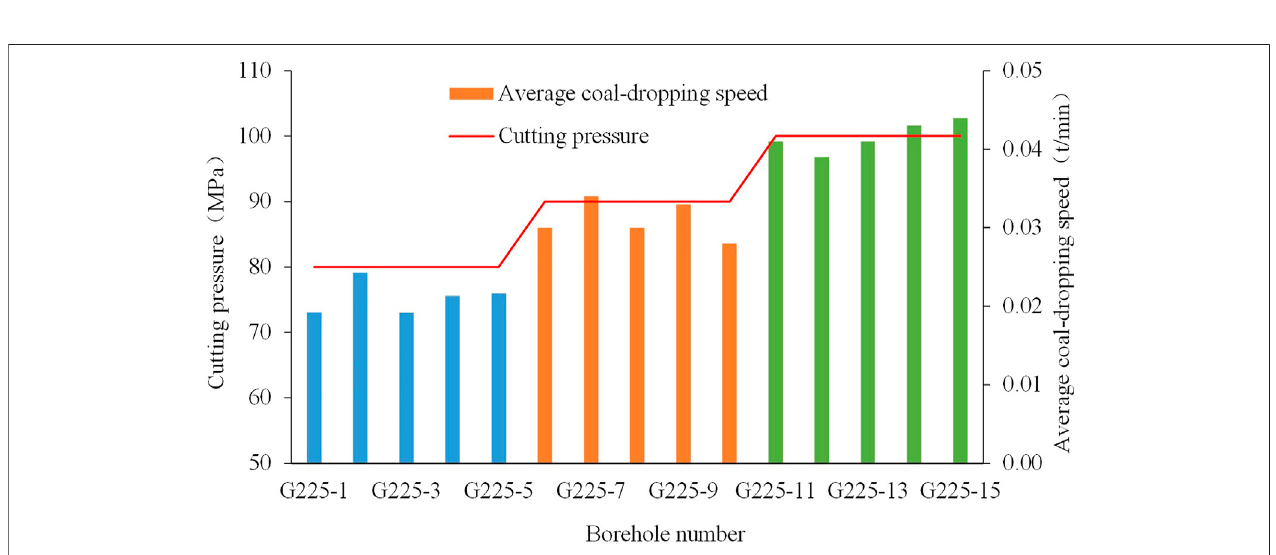
FIGURE 5 | Relationship curve between the cutting pressure and the coal-dropping speed in the coal seam with Protodyakonov coef fi cient within 1.0 – 1.5.